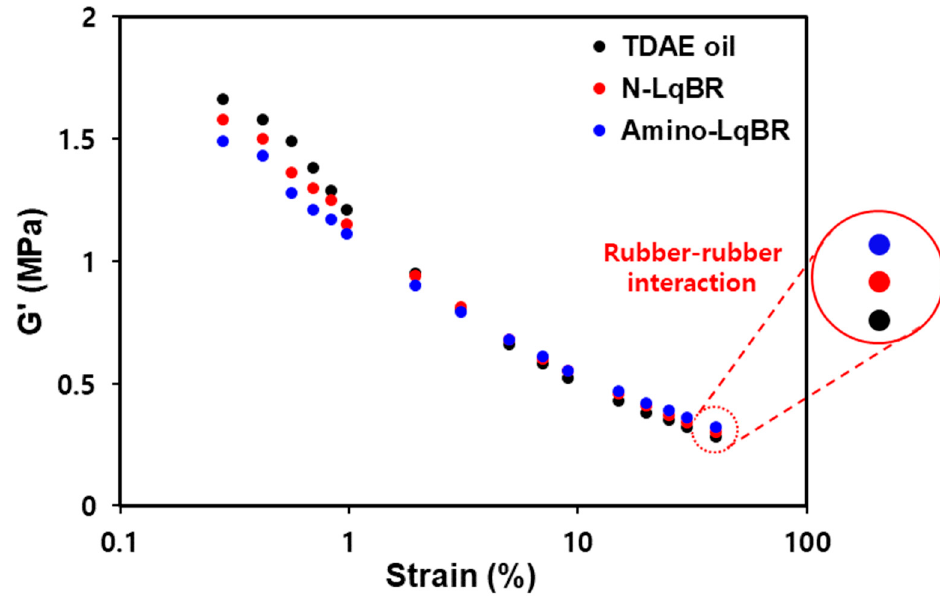
10 of 19 Figure 3. Zero-shear viscosity; ( a ) N-LqBR, ( b ) amino-LqBR. 3.2. Payne Effect The Payne effect generally describes the extent to which a filler network is formed. The smaller the difference is in the storage modulus ( Δ G ′ ) as a result of the filler network being destroyed from increasing strain, the weaker the filler–filler interaction. On the basis of this behavior, the dispersion of fillers in the rubber matrix can be identified. In addition, in the high-strain region where the filler network was destroyed, the G’ of the compound was affected by the hydrodynamic effect, polymer network, and rubber structure [39]. The results of the measurements of the Payne effect of compounds are shown in Figure 4 and Table 5. Carbon black is a hydrophobic filler that exhibits good affinity to hydrophobic rubber. Because LqBR is a hydrophobic rubber, it was also expected to show good affinity to carbon black, and is capable of interacting with it via a Van der Waals force. As a result, the LqBR compounds showed lower Payne effect values than those of the TDAE oil compound due to the improved carbon black dispersion in the rubber matrix. In particular, the amino group at the chain ends of the amino-LqBR compound